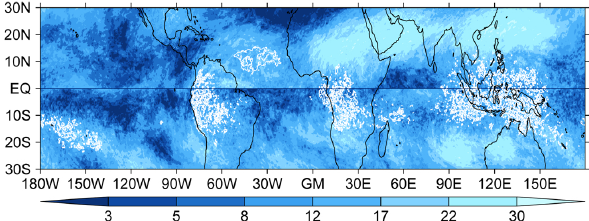
Fig. 6. Map of the tropical belt at 150hPa highlighting regions where higher than average vorticity occurs often (brighter colours mean more events, see colourbar) and where ice supersaturation oc- curs at least on ten of the 31 March days (white contours). Higher than average vorticity is defined here as ζ < − 13 × 10 − 6 s − 1 in the NH and ζ > 13 × 10 − 6 s − 1 in the